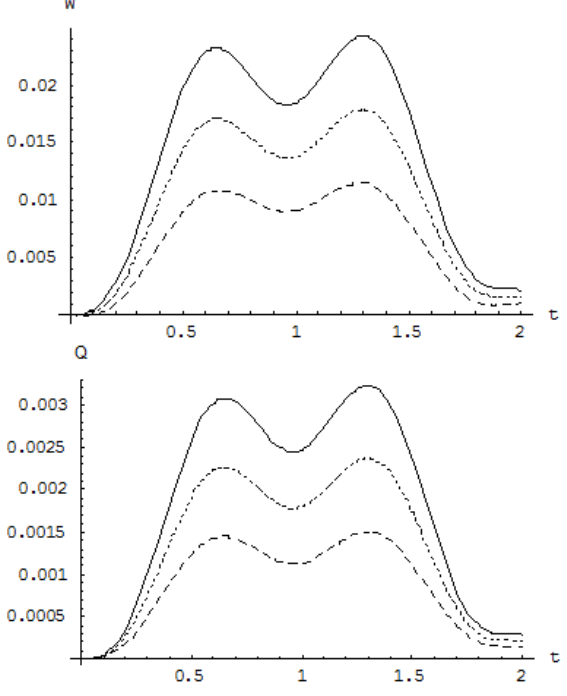
Figure 15: The influence of the eccentricity for υ = 30 m/s, R = 150 m, and ___ e H = 3 m, ...... e H = 0 m, - - - e H = −3 m.